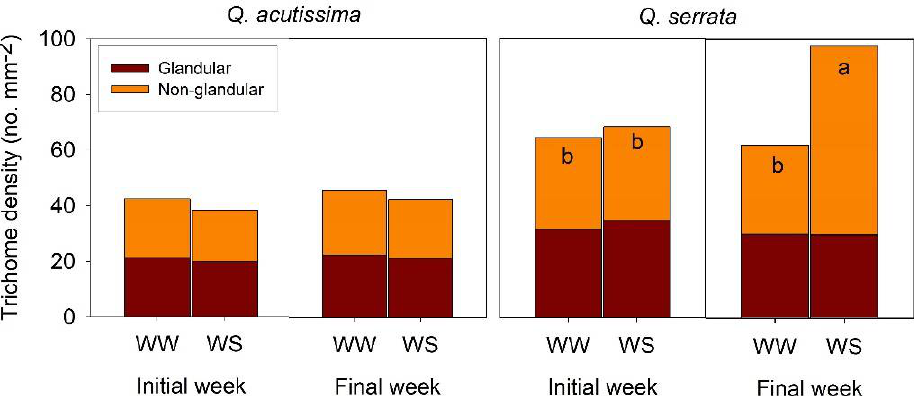
Figure 1. Density of glandular and non-glandular trichomes of Quercus acutissima and Q. serrata in the well-watered (WW) and water-deficit stress (WS) treatments. Comparison means derived using Tukey’s test ( p < 0.05) are shown for the significant interaction between water stress and time. Different lowercase letters indicate significant differences (n = 10). Still-green leaves were the ones harvested for leaf anatomical traits measurement.